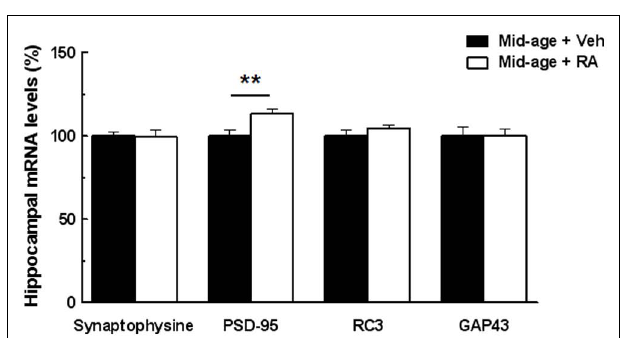
FIGURE 4 | Effects of RA treatment on mRNA expression of hippocampal plasticity-related genes. RA treatment significantly increases PSD-95 mRNA levels. No difference between groups was detected for Synaptophysin, RC3, and GAP-43 mRNA levels. ** p < 0.01 vs Control; by one-way ANOVA, n = 6 per group.